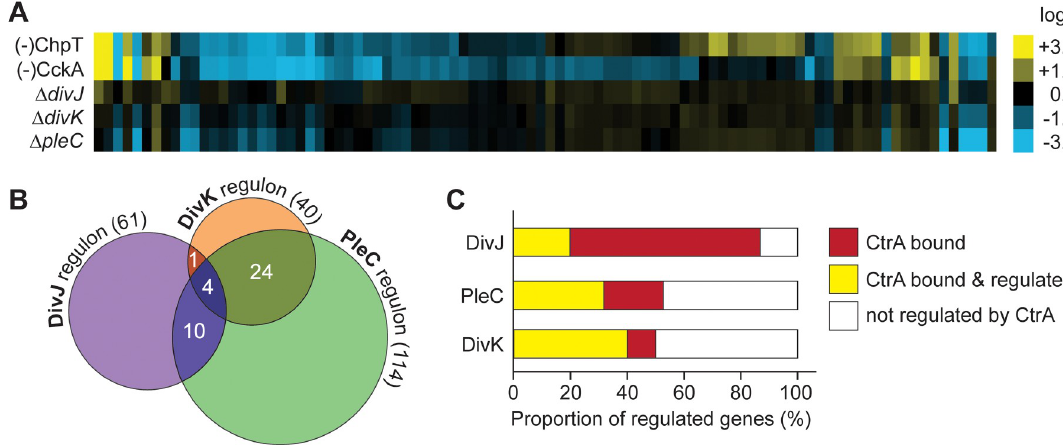
Fig 10. DivJ, PleC and DivK only have a minor effect on the CckA-ChpT-CtrA pathway. (A) Comparison of the transcriptional changes observed for genes in the direct CtrA regulon in the indicated depletion (-) or deletion ( Δ ) backgrounds. Shown are the log 2 - fold changes in transcript levels in the mutant strains as compared to the wild type. (B) Venn diagram depicting the overlap between the regulons of DivJ, PleC and DivK. The number of genes in the respective regulons is given in parentheses. Only genes with an RPKM value of > 25, a p-value of < 0.25 and a log 2 -fold difference of > 0.5 were taken into account. (C) Proportion of genes in the regulons of DivJ, PleC and DivK that are regulated by CtrA. Genes present in the direct CtrA regulon are shown in yellow. Genes that are not included in the direct CtrA regulon but have a CtrA binding site or are in an operon and coregulated with a gene that has a CtrA binding site are shown in red. Genes not regulated by CtrA are shown in white. The same thresholds were applied as in (B) to define the DivJ, PleC and DivK